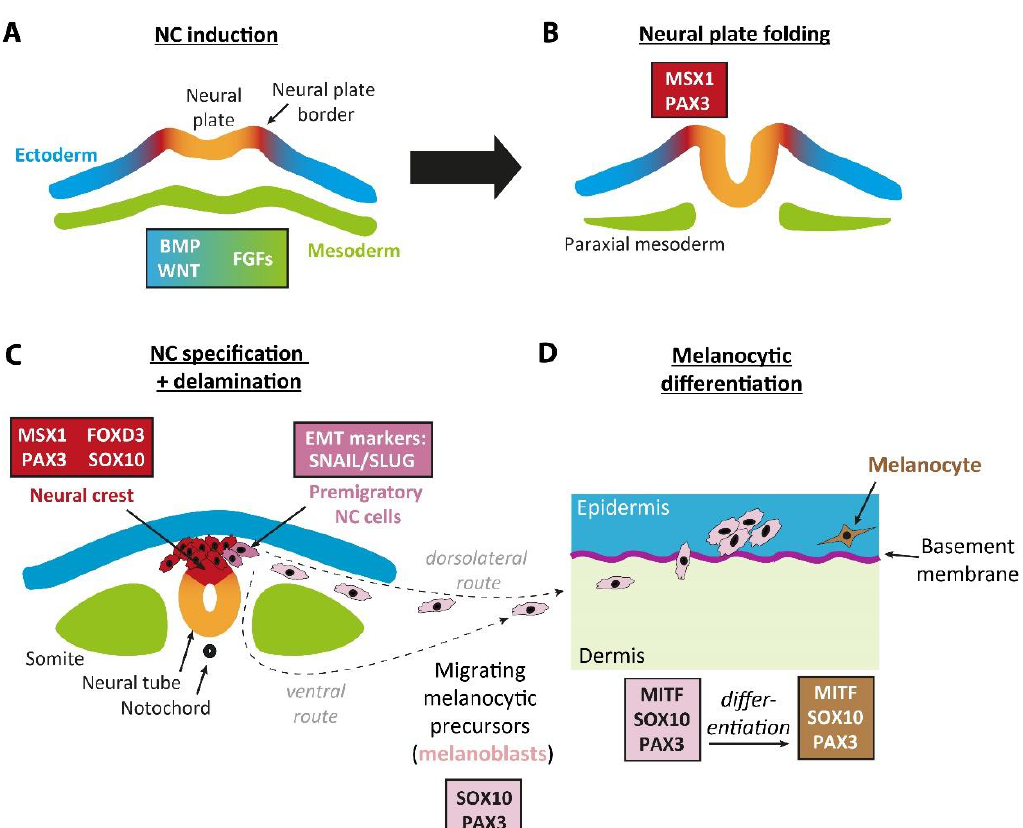
Figure 1. MSX1, FOXD3, SOX10, PAX3, and MITF expression in melanocytic development. ( A , B ) During early embryogenesis, the first phases of neurulation and neural plate folding occur. BMP and WNT secreted by the non-neural ectoderm (blue) and FGFs secreted by mesodermal cells (green) induce MSX1 and PAX3 expression in cells located at the neural plate border (red). These cells later give rise to the NC. ( C ) After the neural plate folding, NC cells (red) form the dorsal part of the neural tube (orange) and express NC-specific markers including MSX1, PAX3, FOXD3, and SOX10. MSX1 also triggers delamination, a process leading to an epithelial-to-mesenchymal transition (EMT) of NC cells that is characterized by an increased expression of transcription factors like SNAIL and SLUG and a switch of cadherin expression. Consequently, multipotent NC cells can migrate to distant sites where they eventually differentiate into distinct cell types, including melanocytes, neurons, glial cells, adipocytes, and smooth muscle cells. NC cells that will later differentiate to melanocytes (pink) mainly migrate on the dorsolateral route (between somites and the ectoderm) towards the dermis; however, a subpopulation also migrates on the ventral route. During this phase of melanocytic development, SOX10 and PAX3 cooperate to activate the expression of MITF, the master regulator of the melanocytic lineage. ( D ) Migrating melanocytic precursors (melanoblasts, light pink) reach the dermis, start to proliferate, and pass the basement membrane to reach the epidermal-dermal junction. After entering the epidermis, the proliferation is even increased. Here, the cells distribute throughout the junctional epidermis and finally differentiate into pigment-producing melanocytes (brown). Orchestrated by MITF and its upstream regulators SOX10 and PAX3, a variety of enzymes, including tyrosinase and dopachrome tautomerase, are expressed that are essential for melanogenesis.